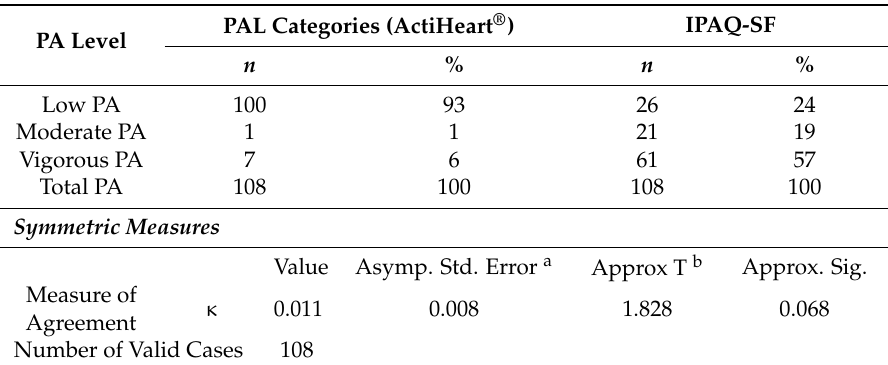
Table 2. Percentages and Cohen’s kappa ( κ ) of physical activity intensity as assessed by ActiHeart ® and IPAQ-SF for different MET